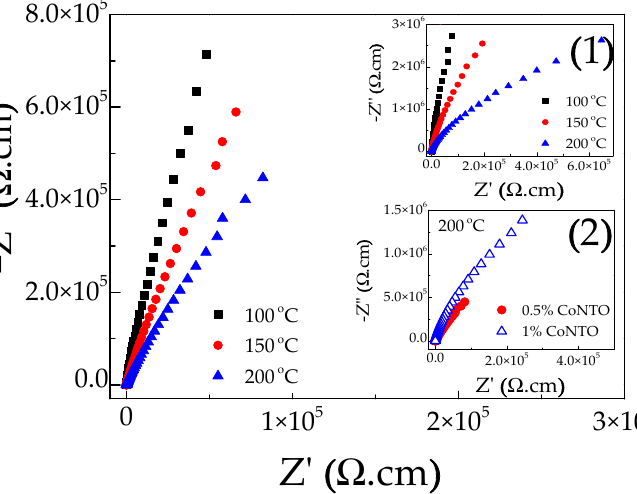
Figure 8. Impedance spectra at different temperatures (100–200 °C) for 0.5% CoNTO ceramic. Inset ( 1 ) shows impedance spectra of 1% CoNTO ceramic at different temperatures and inset ( 2 ) shows the comparison of impedance spectra at 200 °C for 0.5% CoNTO and 1% CoNTO ceramics. To clarify the possible origin of the colossal dielectric properties in 0.5% CoNTO and 1% CoNTO ceramics, we calculated the most stable configurations of 2CoV o TiO 2 and 2NbTiO 2 . To investigate the lowest energy configuration of the 0.5% CoNTO and 1% CoNTO ceramics, the 2CoV o triangular and 2Nb diamond defects were placed into the TiO 2 structure simultaneously in three configurations, for structures 1–3, as shown in Figure 9. The stable structure of 2NbTiO 2 is structure 1 due to the lowest total energy. This result indicates that the 2CoV o triangular defect does not prefer to be close to the 2Nb diamond defect. For the formation of defect clusters of EPDDs, these two types of defects must be close together. However, according to DFT calculations, the lowest total energy can be obtained when the 2CoV o triangular and 2Nb diamond defects are far away. Therefore, it is reasonable to suggest that the colossal dielectric properties of the 0.5% CoNTO and 1% CoNTO ceramics were attributed to the SBLC and IBLC effects, in which the electron hopping mechanism between Ti 3+ and Ti 4+ ions occurred inside the semiconducting grains of the 0.5% CoNTO and 1% CoNTO ceramics.